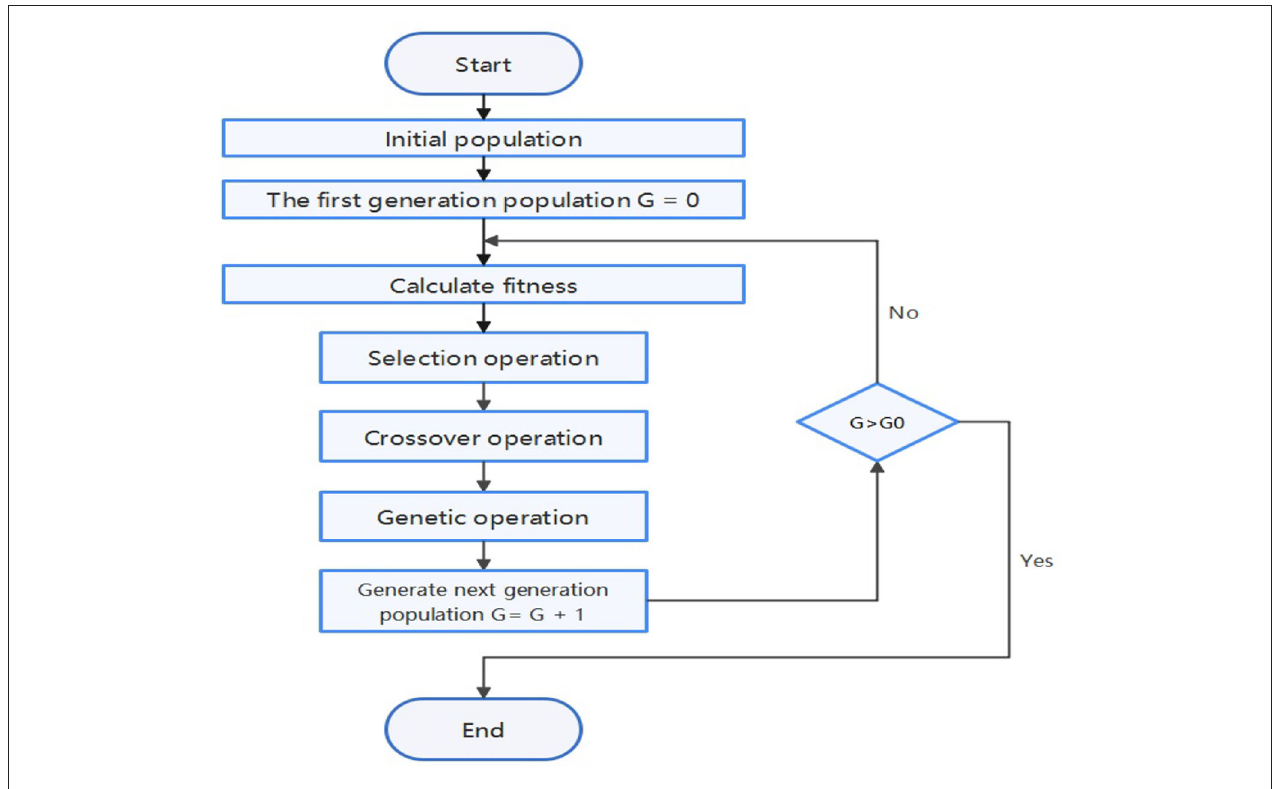
FIGURE 4 | Genetic algorithm flowchart.